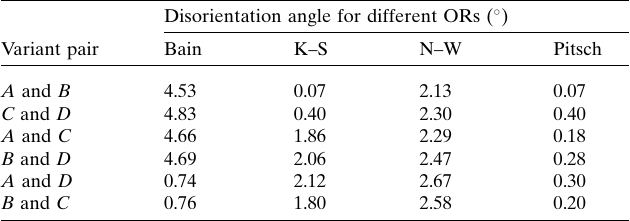
Table 3 Disorientation angles between calculated austenite orientations obtained under different ORs.